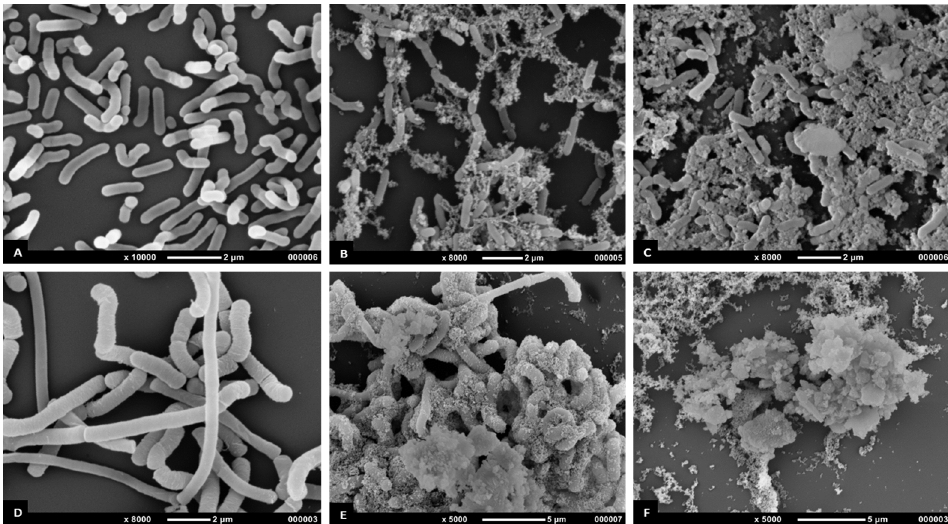
Figure 5. Antimicrobial activity of methanolic ASE of T. ferdinandiana fruits and leaves. SEM images of Listeria monocytogenes treated with control ( A ), fruit extracts ( B ), and leaf extracts ( C ), and Bacillus cereus treated with control ( D ), fruit extracts ( E ), and leaf extracts ( F ). Samples were imaged in a Jeol Neoscope JCM 5000 at an accelerating voltage of 10